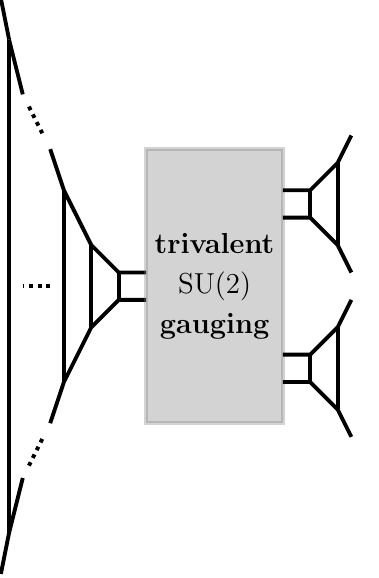
Figure 2 . A 5-brane web-like description of the theory (2.3) which is dual to the pure SO(2 N + 4) gauge theory. The prescription for the \trivalent SU(2) gauging" is going to be given in the next section. Three webs actually does not live in the same plane, and thus do not cross each other in the cases we will deal with in this